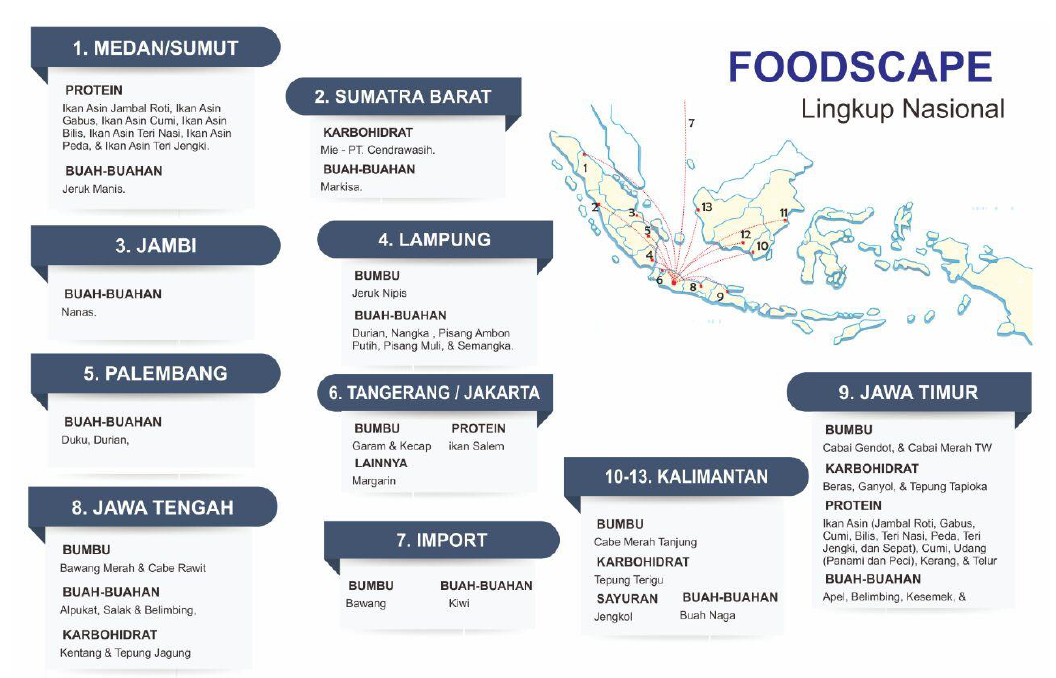
Fig. 3 Food Transmission from West Java to Bandung